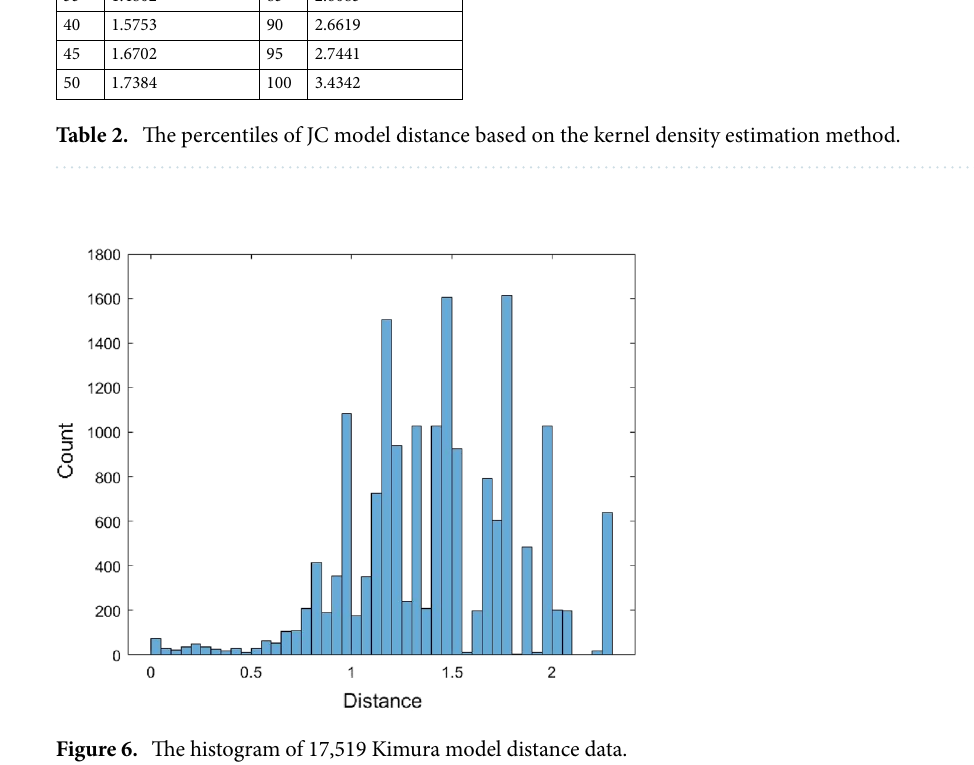
Figure 6. The histogram of 17,519 Kimura model distance data.